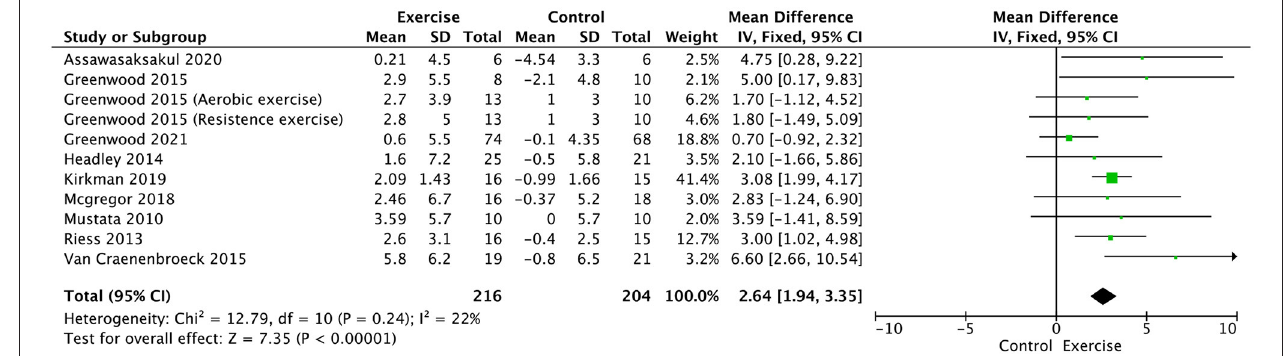
FIGURE 5 | Forest plot of exercise training on peak VO2.